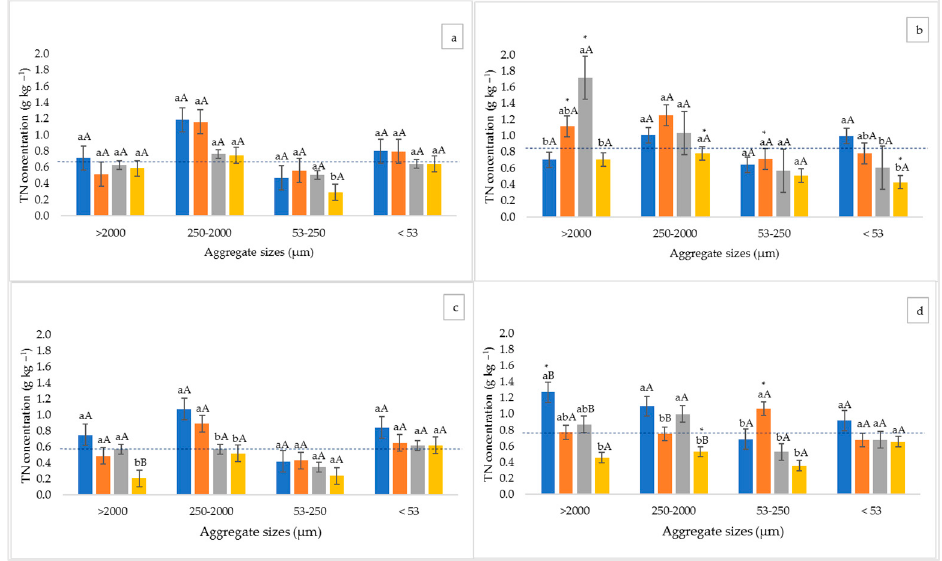
Figure 7. Aggregate-associated total nitrogen (TN) concentration (g kg − 1 ) in different sizes of soil water-stable aggregates for conventional-tillage (CT; blue bars); saffron (D-S; orange bars); oats (D-O; grey bars) and lavender (D-L; yellow bars) treatments at ( a ) 0–10 cm depth (2018), ( b ) 0–10 cm depth (2021), ( c ) 10–30 cm depth (2018) and ( d ) 10–30 cm depth (2021). The different lowercase letters above the error bars for the same soil layer indicate significant differences between managements at p < 0.05. Different capital letters are indicating differences in depth. Each cultivation system (*) represents significant differences with respect to the olive monocrop conventional tillage system in 2018 (control treatment) by Dunnett’s test (* p < 0.05). Missing asterisks denote non-significant differences.